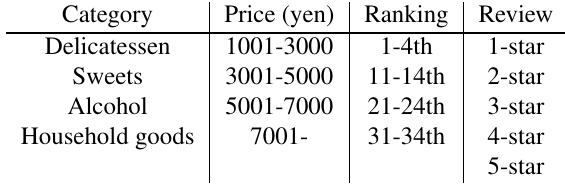
The attributes and attribute values used in the